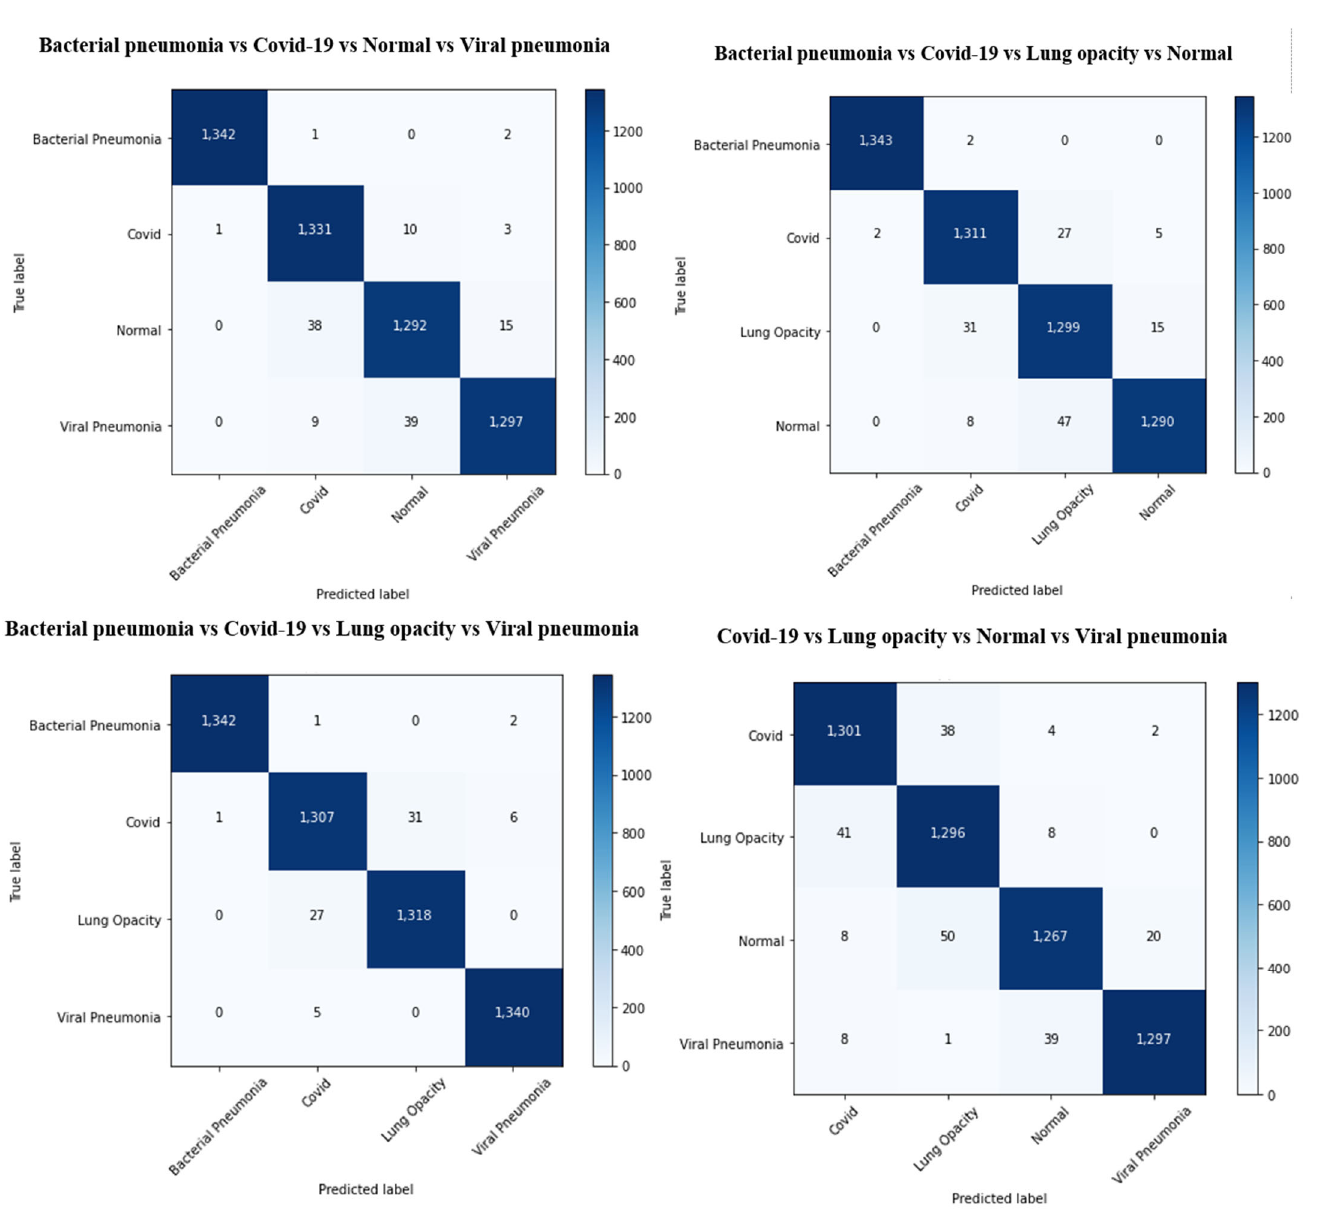
Figure 5. Overlapped confusion matrix of 4 ‐ class classifications.